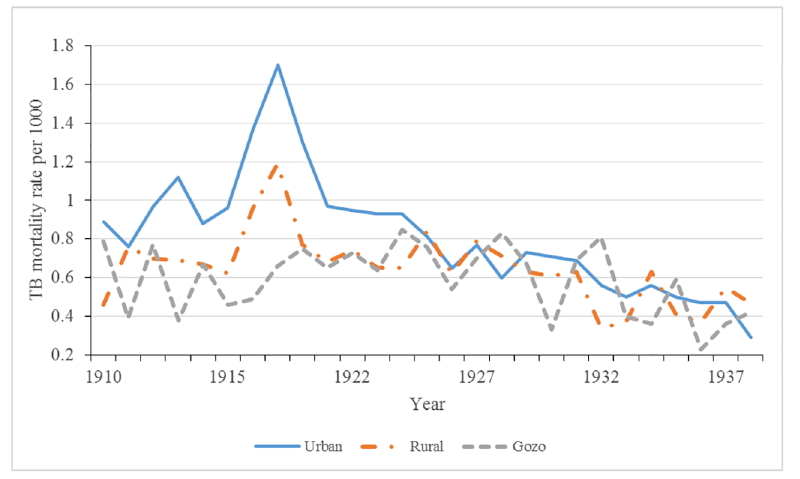
Fig 10. Tuberculosis mortality rates by settlement type: Malta 1910–1938.